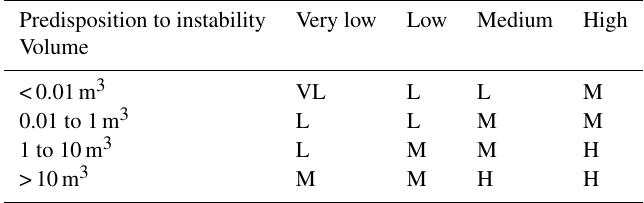
Table 7. Assessment of the rockfall hazard with the SMR method.